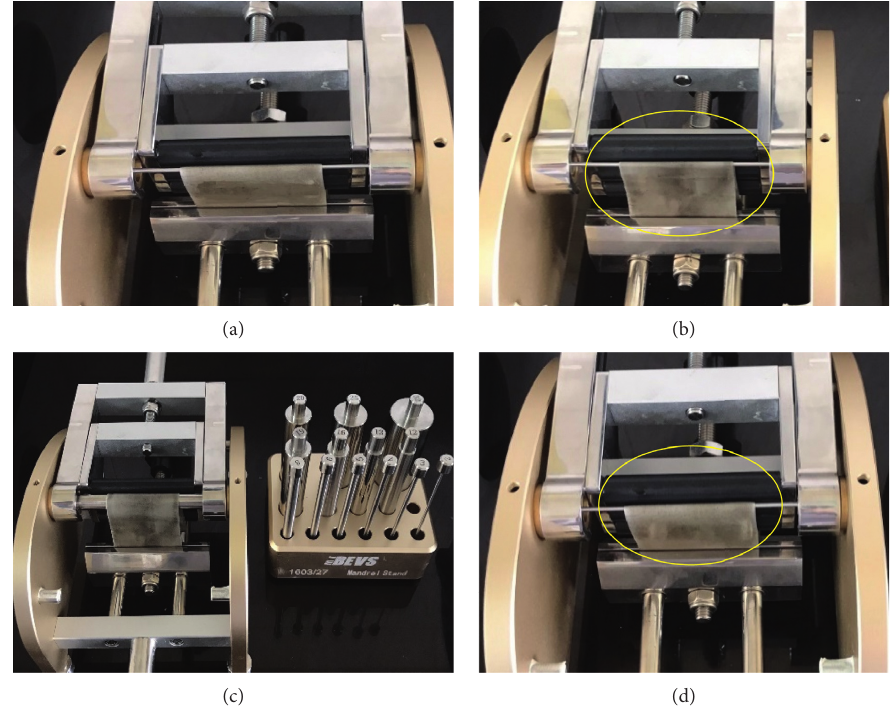
Figure 3: Image of flexural strength measurement of coating materials: (a) F1 ( 0.5 wt.% MWCNTs, 10 wt.% FA). (b) F2 (1 wt.% MWCNTs, 10 wt.% FA). (c) F4 (1 wt.% MWCNTs, 0 wt.% FA). (d) F3 (1.5 wt.% MWCNTs, 10 wt.% FA).